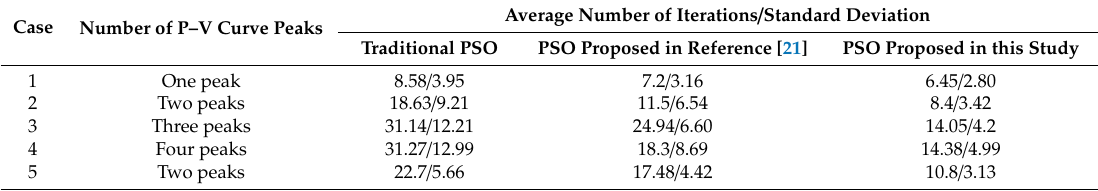
Table 6. Comparison of simulation results of five case simulations